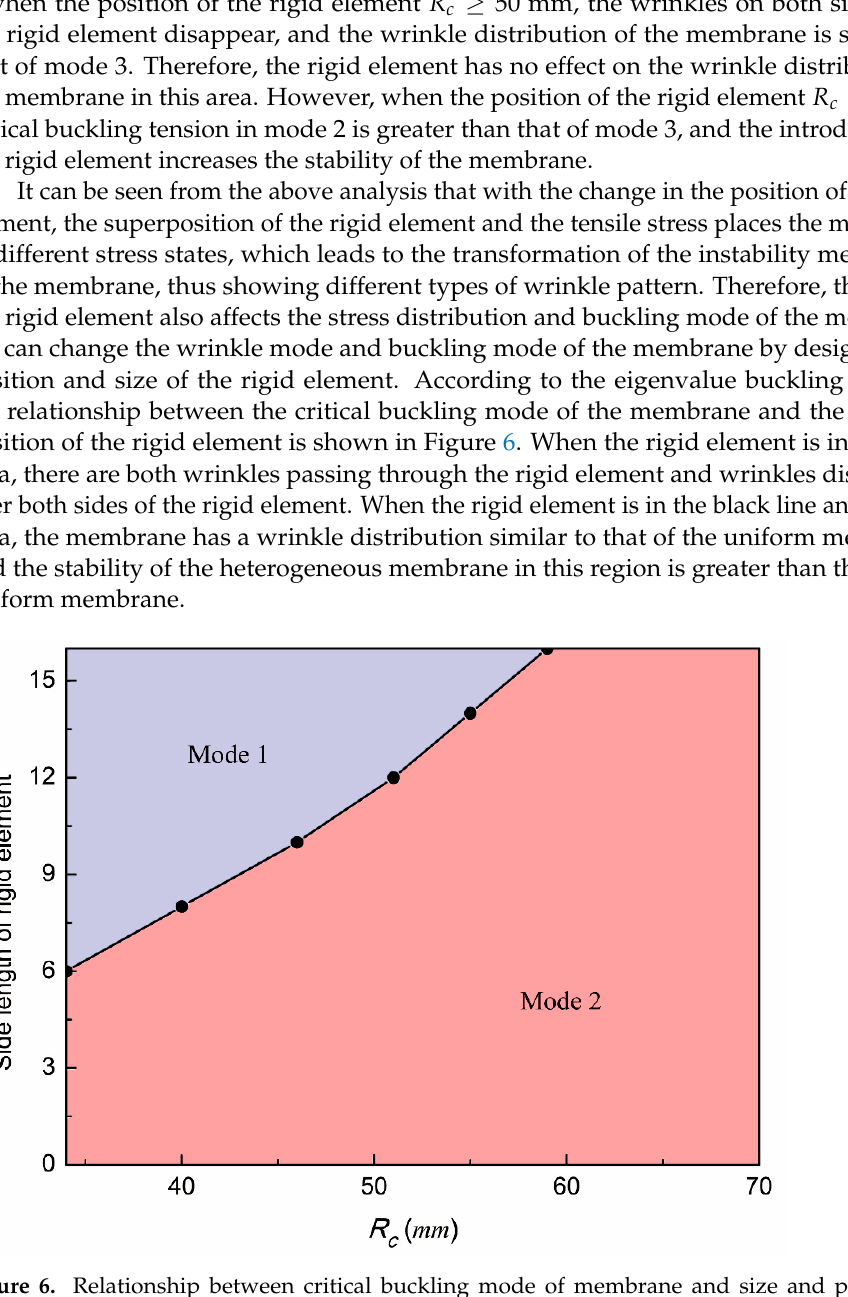
Figure 6. Relationship between critical buckling mode of membrane and size and position of rigid element. rigid